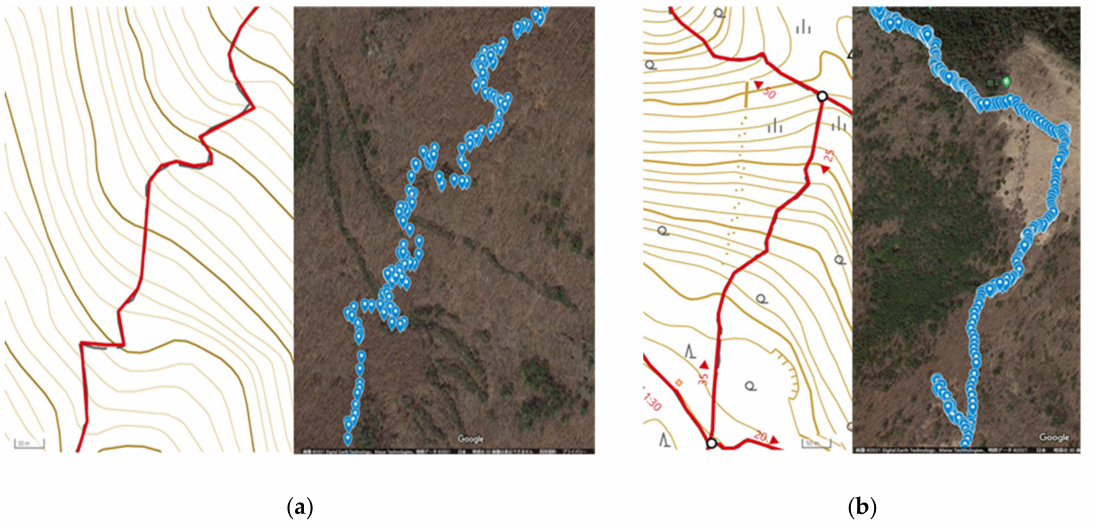
Figure 10. The comparison of log of the actual route of Mt. Kentoku. ( a ) The actual route and the GPS-recorded route in the mountainous area. ( b ) The actual route and the GPS-recorded route in the open and clear area.